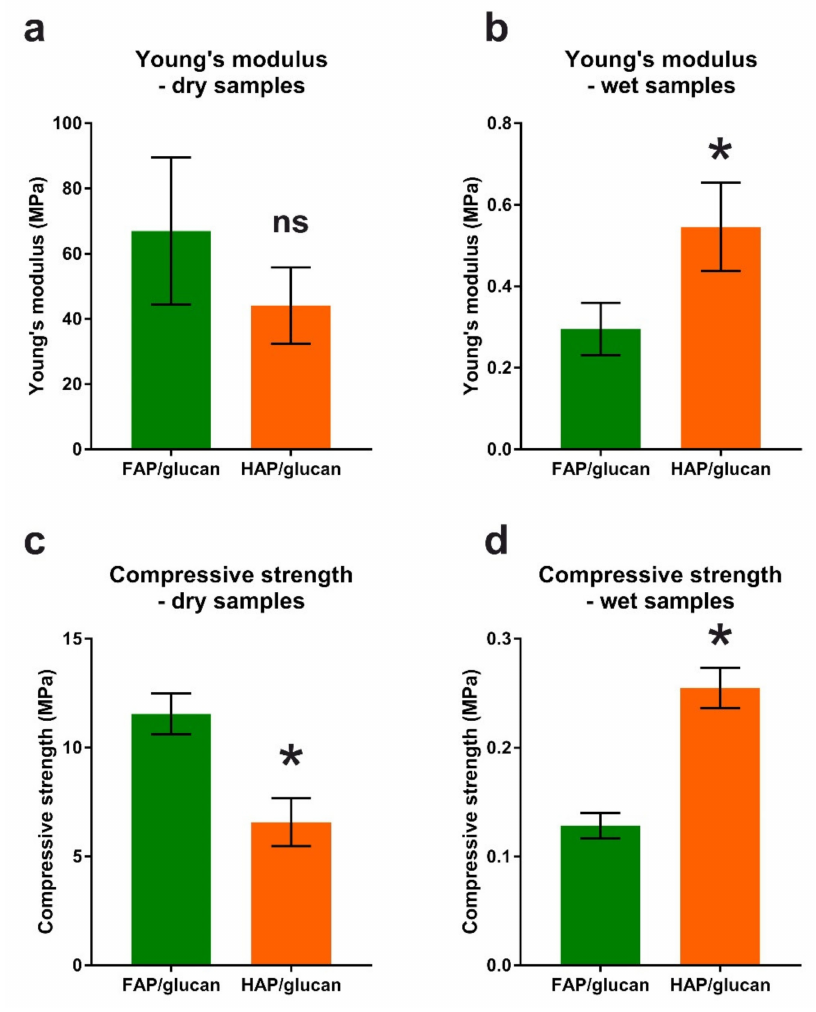
Figure 4. Mechanical parameters of composites measured in a dry state and after a 24-h soaking in deionized water. *, statistically significant difference between FAP/glucan and HAP/glucan composites according to unpaired Student’s t -test; ns, no